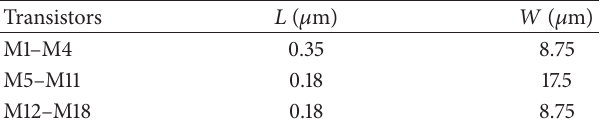
Table 1: Aspect ratios of the MOS in Figure 2. Table 2: Input and output noises against frequency for noninverting bandpass